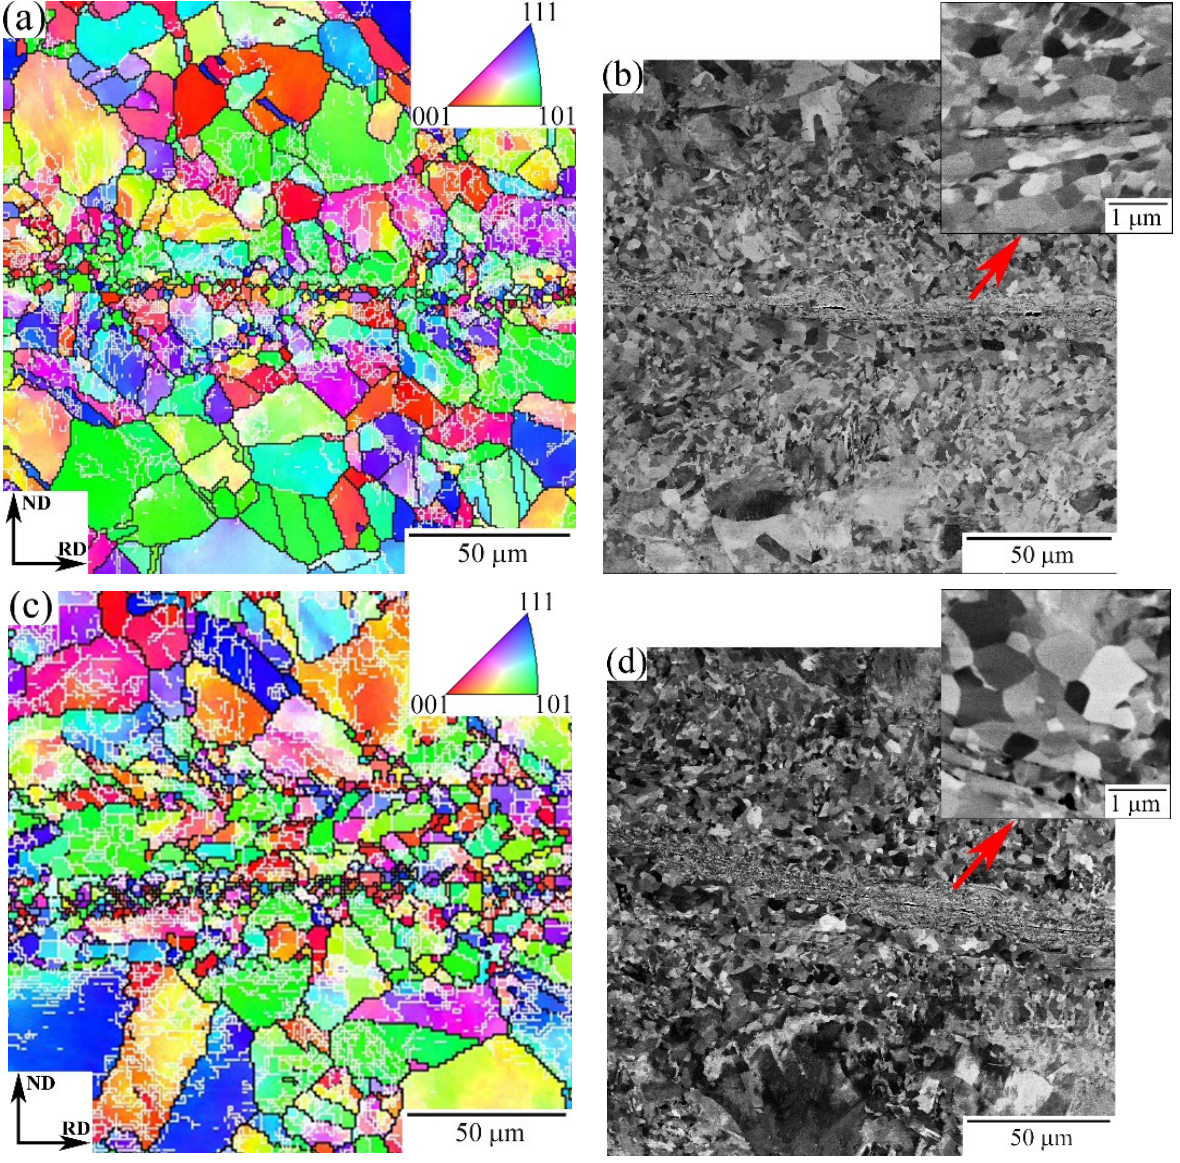
Figure 8. Crystal orientation maps ( a , c ) and BSE images ( b , d ) of the ultrasonically welded joints obtained under clamping forces 4.5 kN ( a , b ) and 6 kN ( c , d ) from the samples with initial CG microstructure.